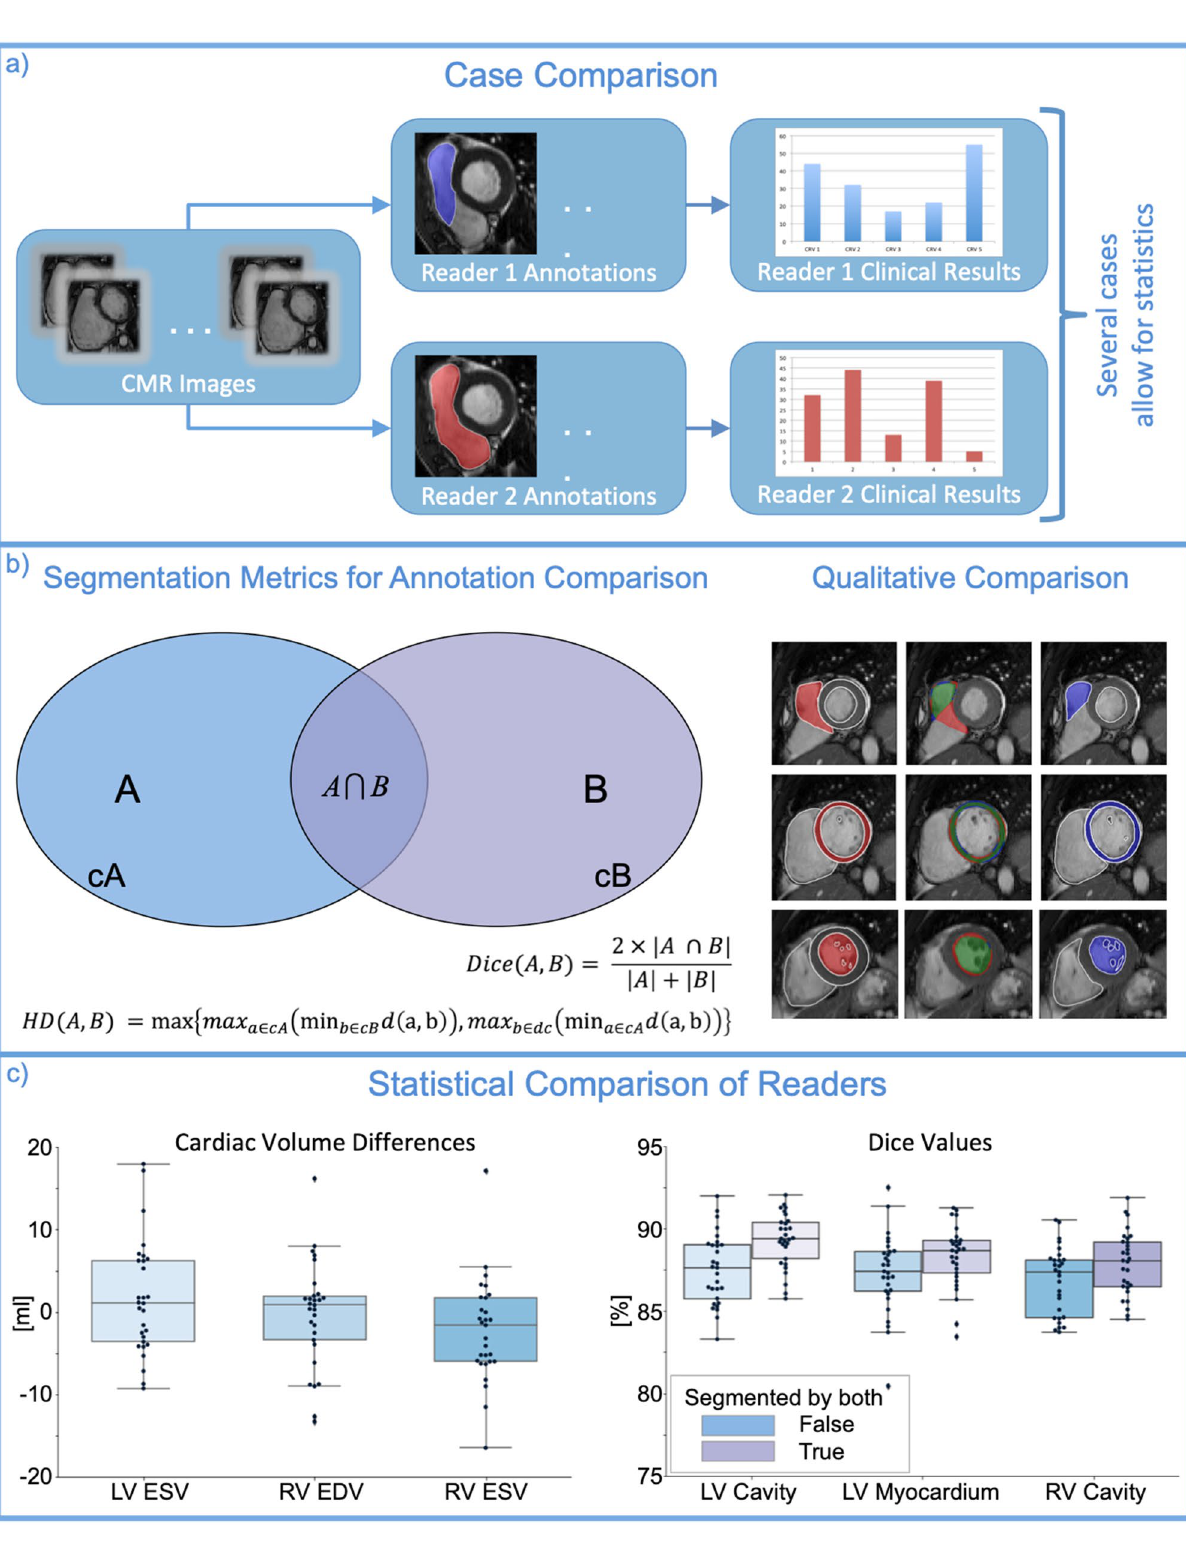
Figure 1. Multilevel Reader Comparison. Caption: At the top ( a ) a case comparison is presented. Comparable cases concern CMR images that were segmented by two different readers. Clinical results are generated from images and segmentations. Segmentation metrics ( b ), such as Dice and Hausdorff metric, provide quantitative comparisons of segmentations. Next to the metrics, qualitative visualizations of segmentation differences are presented. The first reader’s segmentation is coloured blue, the second red and their agreement in green. Reader comparisons are modelled as the distributions of clinical result differences and metric value distributions. LV: Left ventricle, RV: Right ventricle, ESV: End-systolic volume, EDV: End-diastolic volume, cA (cB): Contour of Area A, ml: Millilitre, HD: Hausdorff